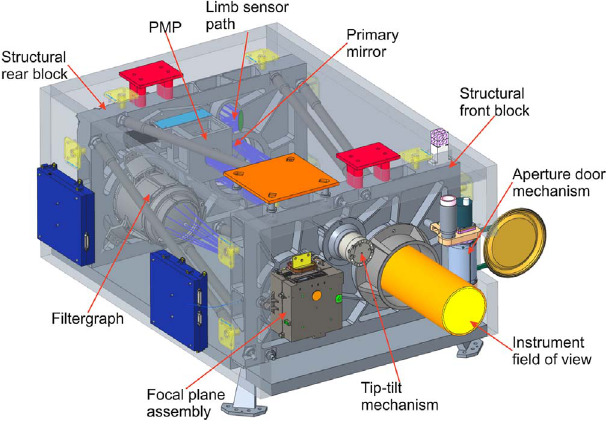
Fig. 6. Preliminary con fi guration of the optics unit.